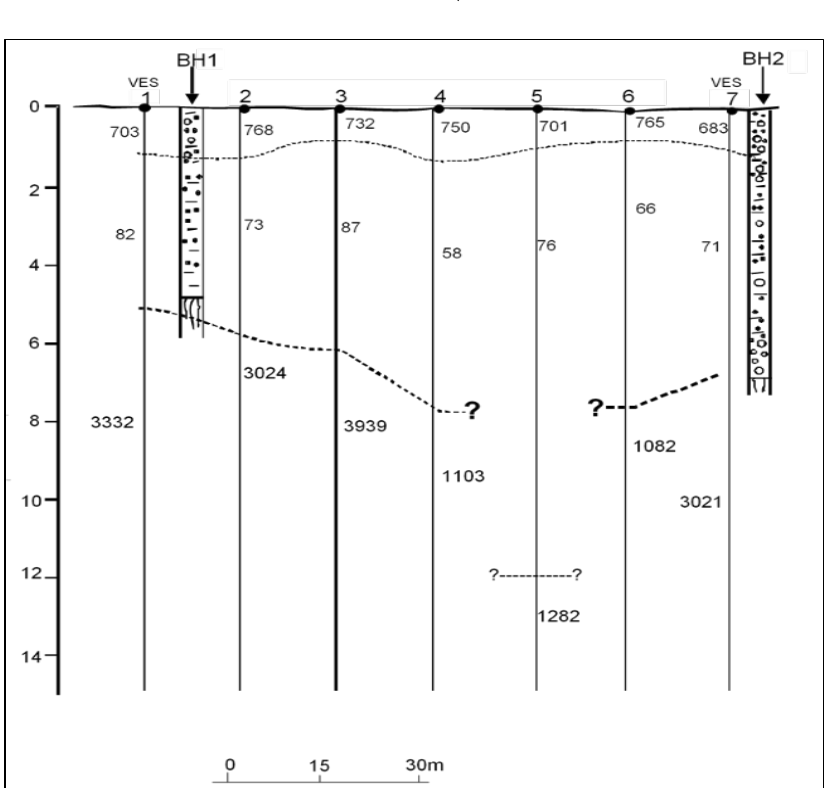
Figure 4: Correlation between Geoelectric Section and Lithological Section. Source: Authors,